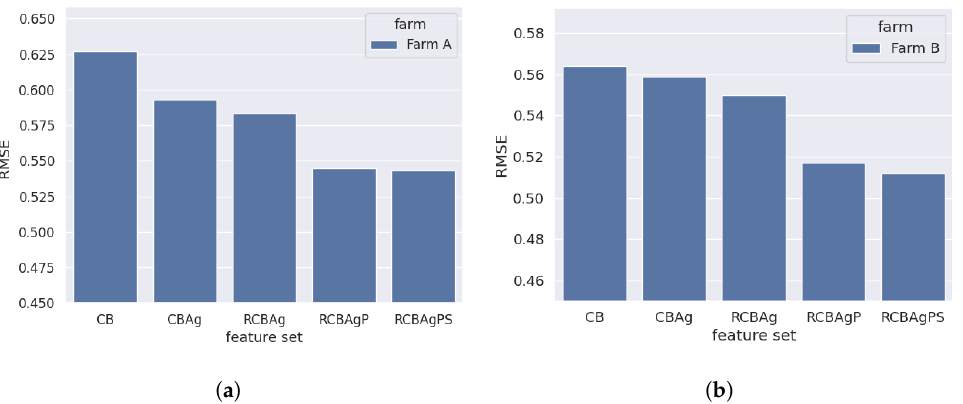
Figure 6. Feature selection algorithm results for both wind farms. For both farms, the biggest accuracy gain is obtained after including gradients of wind speed and direction into the feature set—RCBAgP. For both cases, we used the RMSE metric. ( a ) Farm A—feature selection procedure results. ( b ) Farm B—feature selection procedure